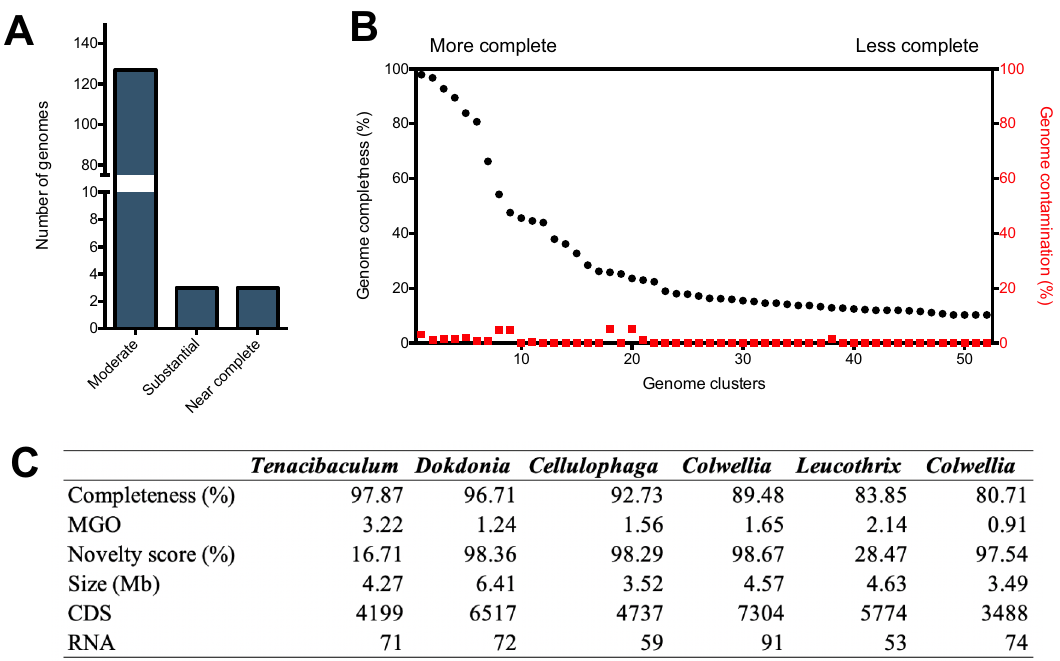
Figure 1. Summary of the genomic reconstruction of bacterial clusters associated with Caligus rogercresseyi . ( A ) Genome cluster classification according with their completeness in near complete (> 95%), substantial (> 80%), and moderate (< 80%). ( B ) Genome completeness and contamination among the 50 most represented bacterial clusters. ( C ) Main genomic features of the top 5 represented genomes clusters in sea lice